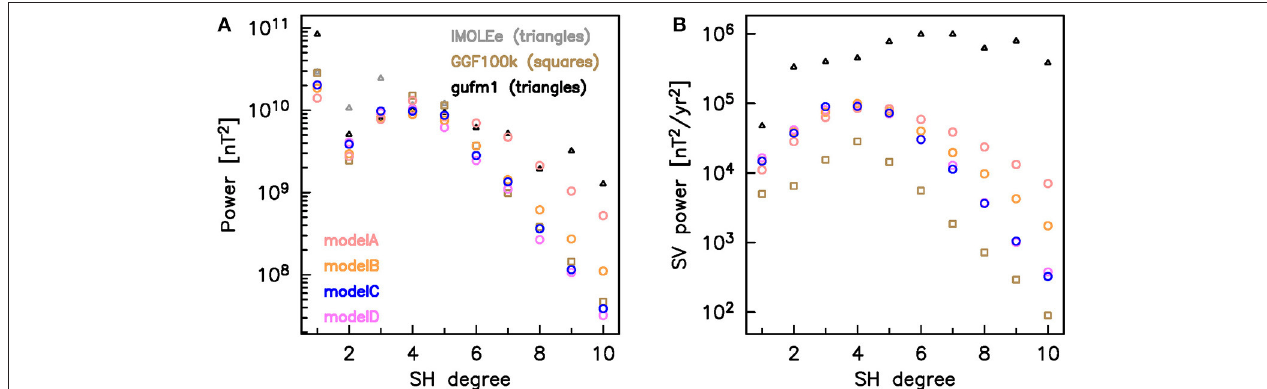
FIGURE 4 | Power spectra at the CMB for (A) the time-averaged field and (B) its secular variation of the six models. All averages are calculated over 44–36 ka. Model C (LSMOD.2) is our preferred model. The 400 years average spectra of the historical model gufm1 are shown for